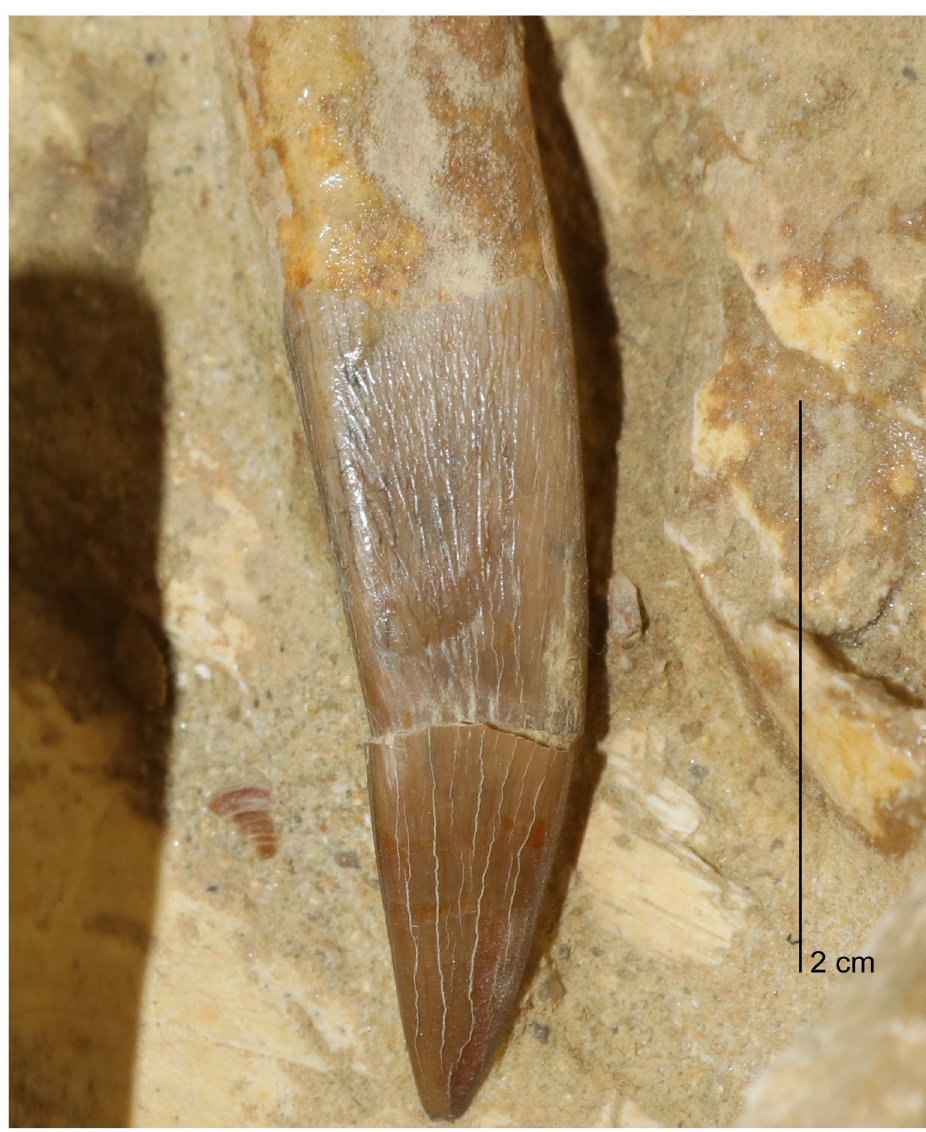
Fig 17. Tooth associated with Cardiocorax mukulu (MGUAN